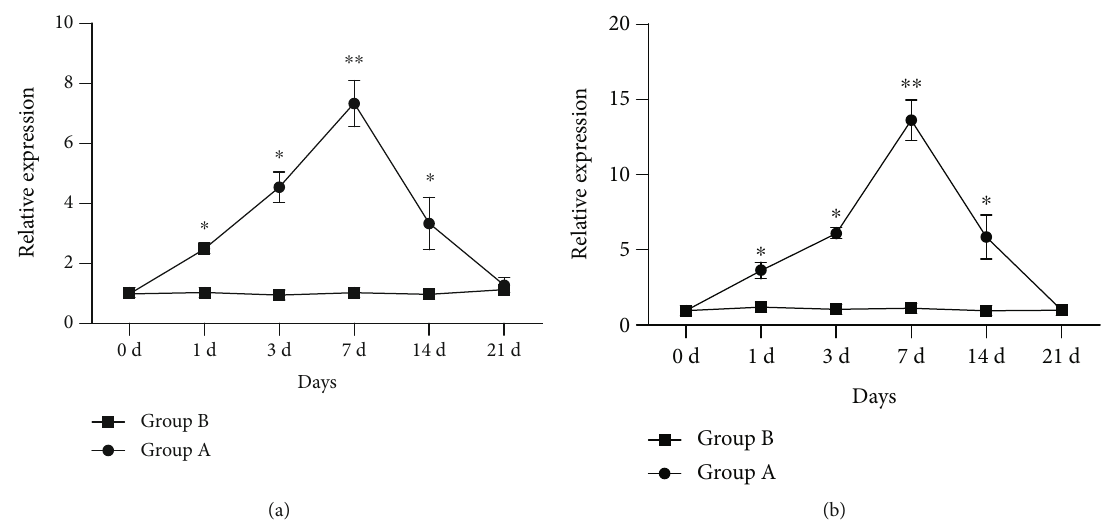
Figure 2: Expression of TNF- α mRNA and IL-1 β mRNAs in blood of experimental rabbits. Group A: monocular phacoemulsi fi cation; Group B: blank control.